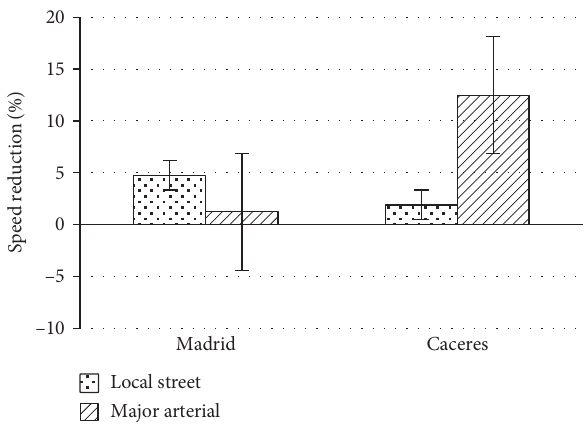
Figure 9: Impact of eco-driving on average speed.